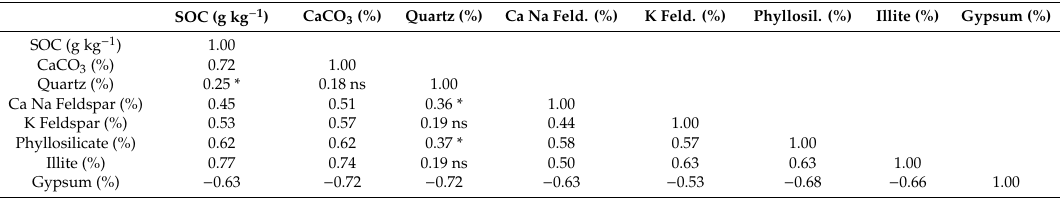
Figure 2. Soil reflectance, VIS / NIR range (4050–1050 nm). Average (short-dashed lines) and standard deviation of samples from 10, 20 and 30 cm depth in brackets on the right (n = 30). Table 2. Spearman correlations of physical–chemical variables of samples (n = 90). All the correlations are significant at p < 0.01, except those marked with * which are significant at p < 0.05, or with “ns” which are not significant.